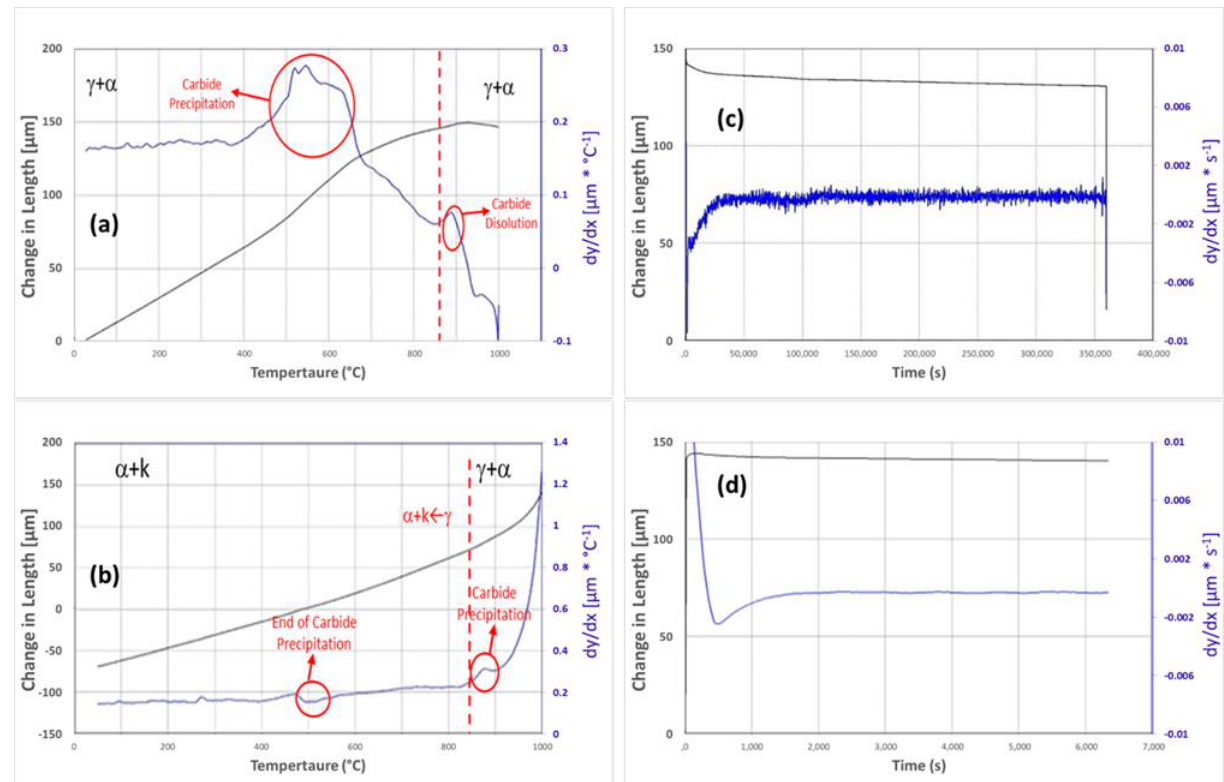
Figure 4. Dilatometry tests. ( a ) The curve (black) and its derivative (blue) corresponding to the heating process up to 1000 °C; ( b ) curves for the reverse cooling process; ( c ) curve (black) and its derivative (blue) corresponding to an isothermal treatment (750 °C-100 h); ( d ) detail of the beginning of the isothermal treatment. The symbols γ, α and k refer to austenite, ferrite and k-carbide phases, respectively.